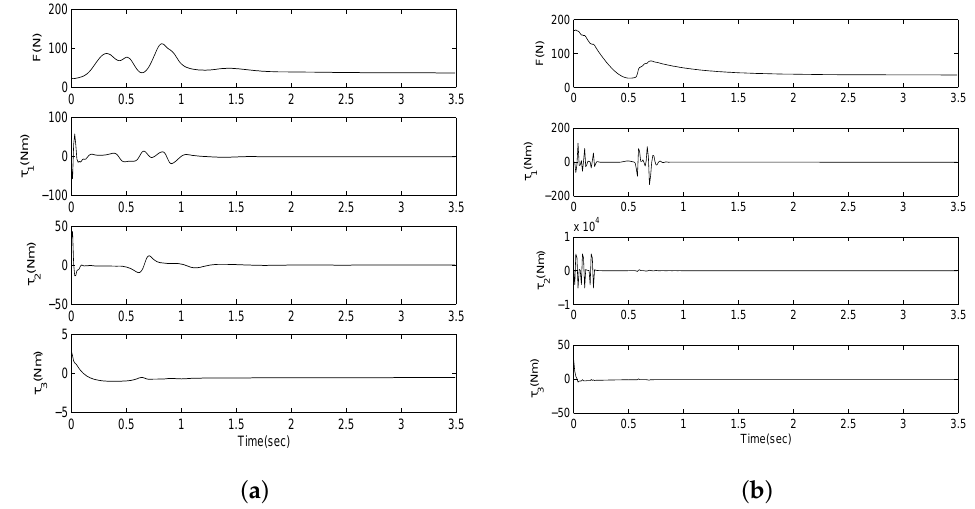
Figure 4. Control inputs: ( a ) Proposed method; ( b ) RBS-SMC